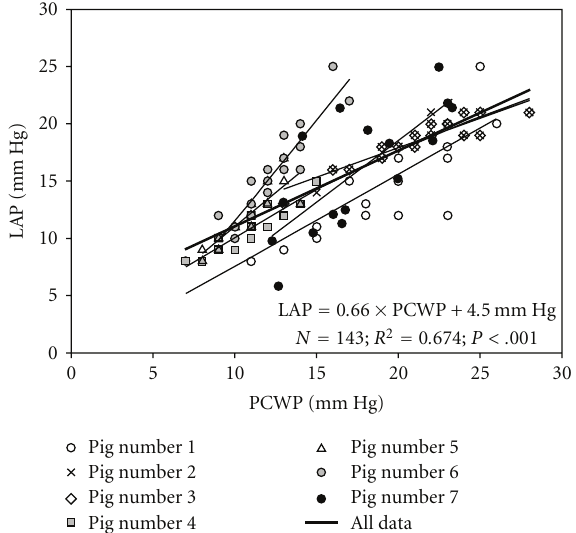
Figure 2: Regression data comparing left atrial pressure (LAP) to pulmonary capillary wedge pressure (PCWP).